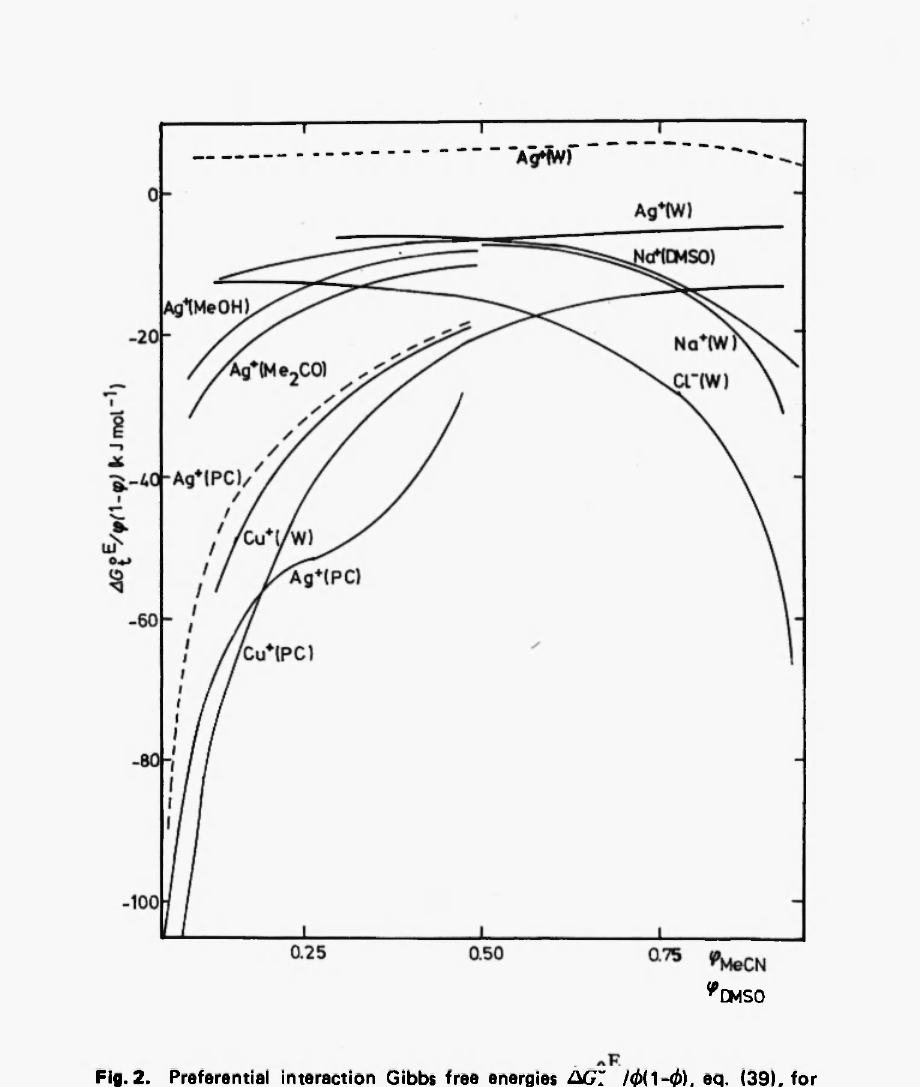
Fig. 2. Preferential interaction Gibbs free energies Ιφ(}-φ), eq. (39), for transfer of the indicated ions from the indicated solvents into their mix- tures with acetonitrile (solid lines) or dimethylsulfoxide (dashed lines), plotted against the volume fraction φ of the latter solvent in the mix- ture (after ref.